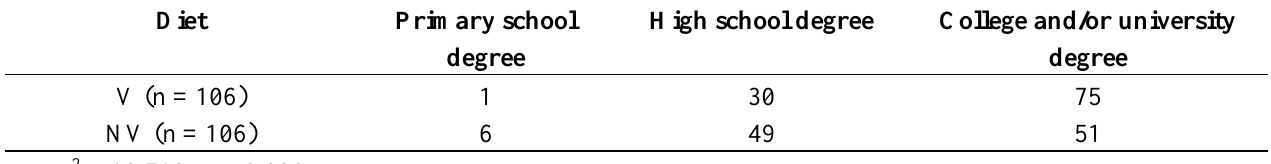
Table 3. Educational level (primary school degree, high school degree, college and/or university degree) in the vegetarian (V) and the omnivorous (NV) subjects.